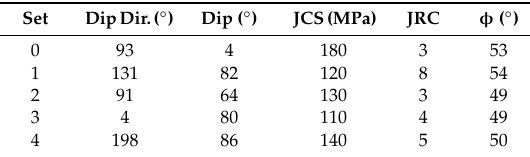
Table 1. Main geomechanical features of the joint sets recognized through remote and direct surveys.